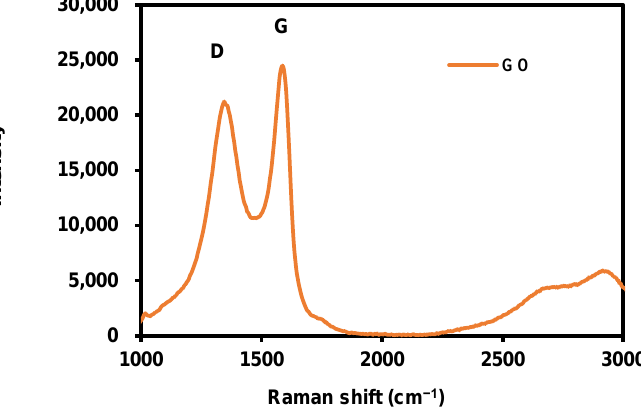
Figure 3. Raman spectra of synthesized graphene oxide (GO).